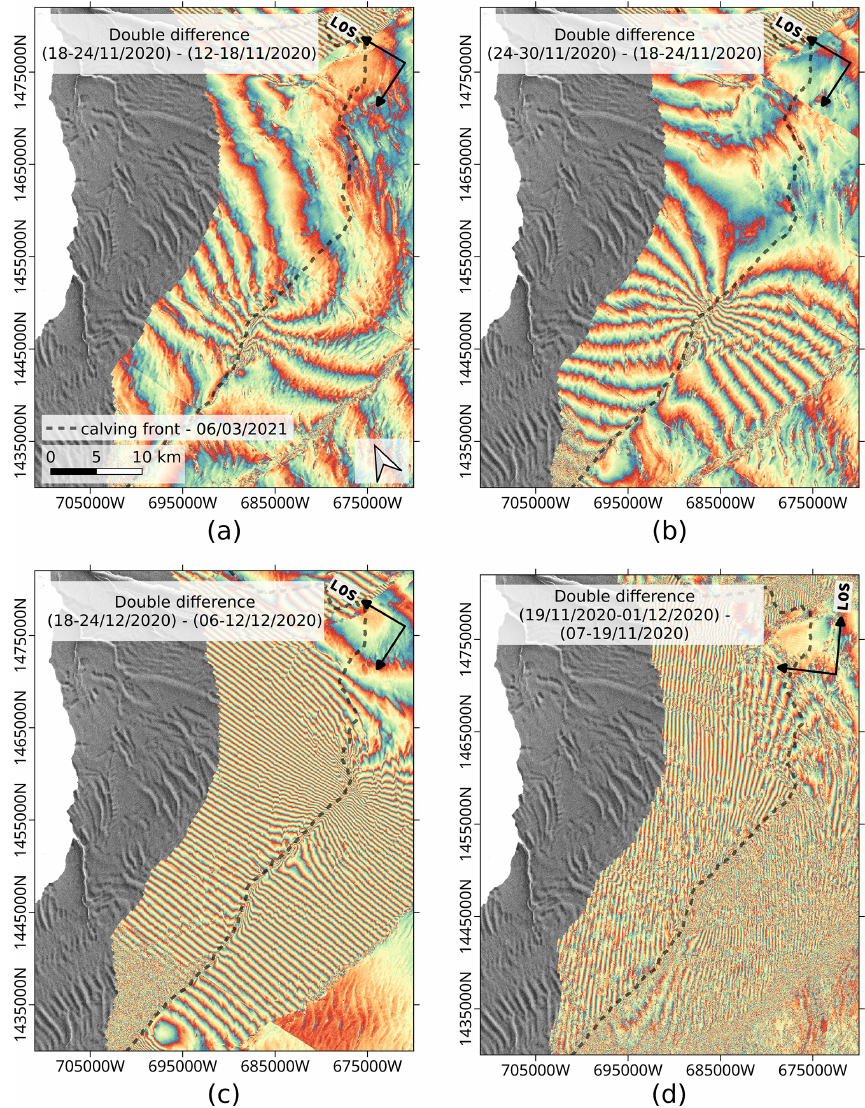
Figure 13. Difference between consecutive repeat-pass interferograms showing the strain pattern variation as the North Rift propagates. Panels (a) – (c) are calculated from 6d interferograms of track 50 shown in Fig. 7. Panel (c) is calculated from 12d interferograms of track 164 (not shown). The black dashed line indicates the full extent of the North Rift. (a) Difference between 18–24 and 12–18 November 2020 (track 50). The crack starts to propagate. (b) Difference between 24–30 and 18–24 November 2020 (track 50). The crack propagates as a straight line along a given direction. (c) Difference between 18–24 and 6–12 December 2020 (track 50). The crack has almost reached the Stancomb–Wills Chasm. (d) Difference between 19 November–1 December and 7–19 November 2020 (track 164). The crack has reached its diverging